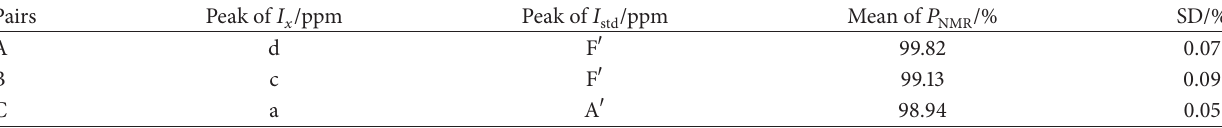
“ 𝑛 ” means different data sets measured under the same conditions.